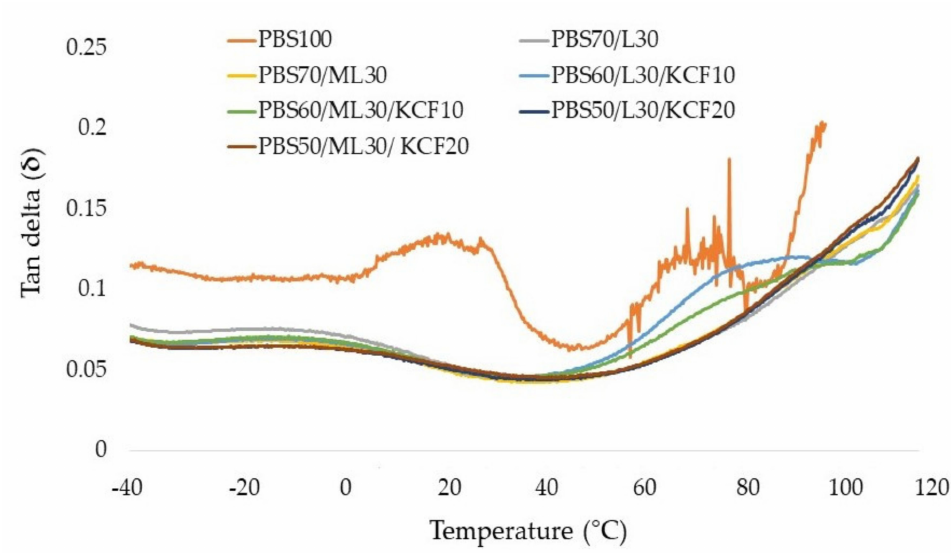
Figure 5. Tan delta ( δ ) of the composites prepared from an unmodified and modified lignin blend with PBS and kenaf core